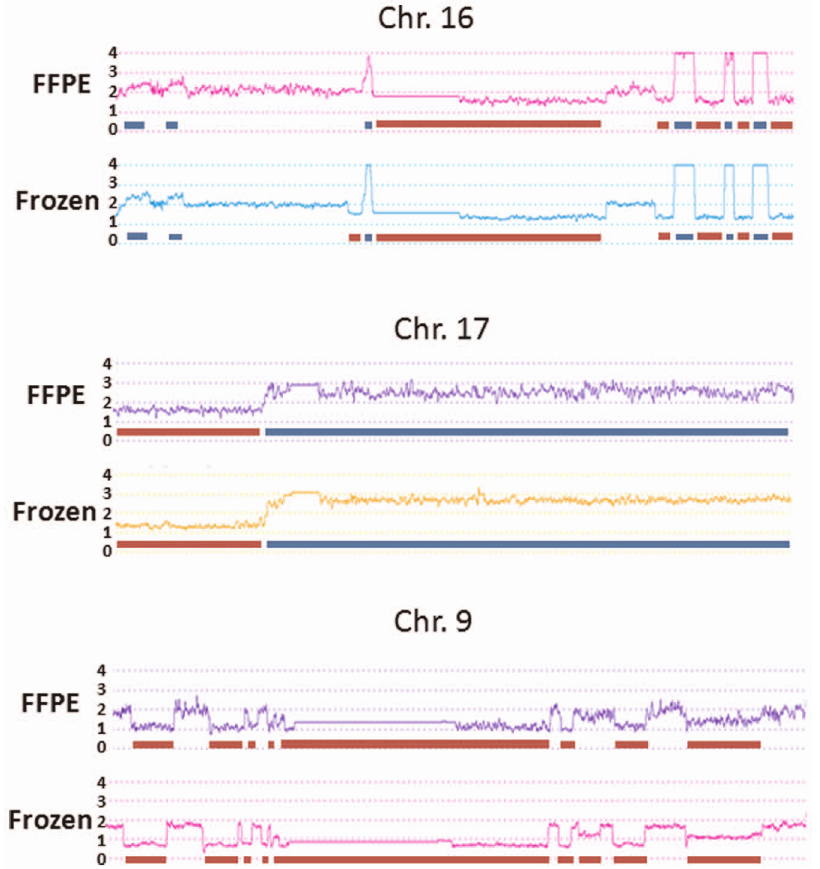
Figure 1. Histograms of matched FFPE and Fresh frozen samples on selected chromosomes. Top panel: FFPE and frozen histograms of chromosome 16 of Case 1; Mid panel: FFPE and frozen histograms of chromosome 17 of Case 2; Lower panel: FFPE and frozen histograms of chromosome 9 of Case 4. Red bar denotes deletion. Blue bar denotes amplification.